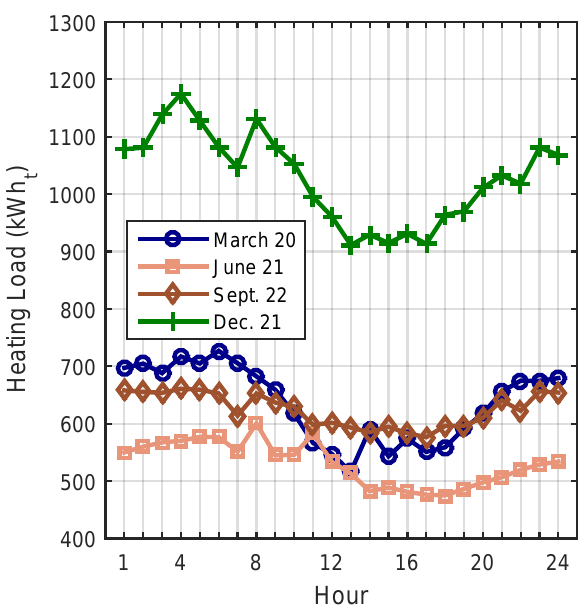
Figure 3. Average heating load of the districts of buildings.